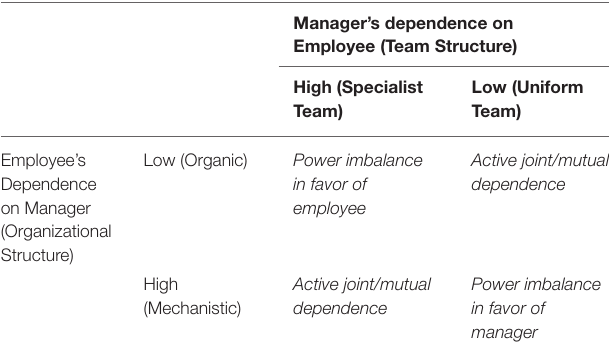
TABLE 1 | Dependence relationships: Contingencies—team and organizational